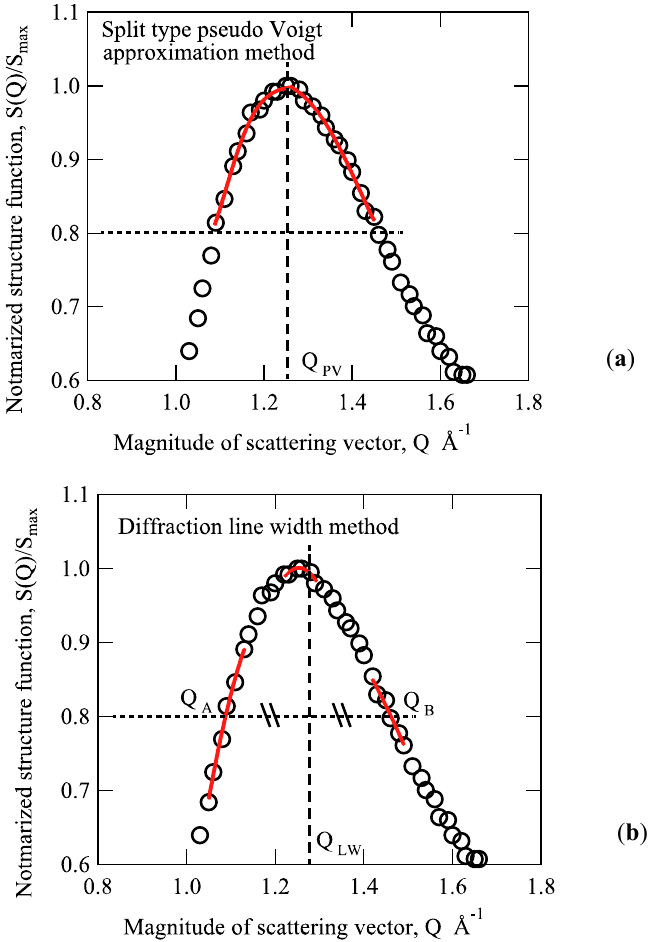
Figure 2. Determination method of peak position: ( a ) Approximation by split type pseudo Voigt function using more than 0.8 S max data; ( b ) Average of two intersection positions corresponding to the intensity of 0.8 S max .